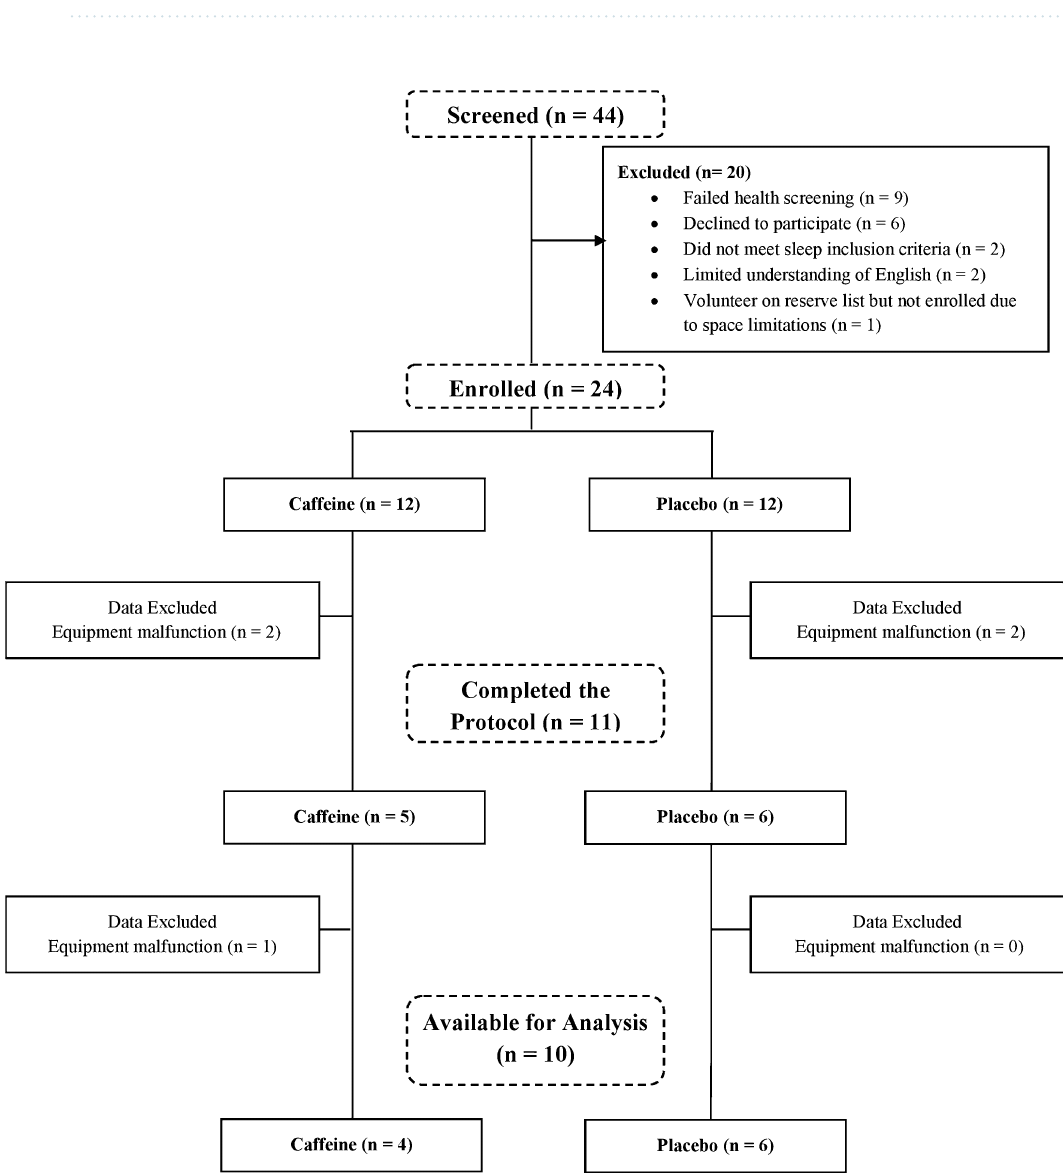
Figure 5. Consort diagram of participant screening, allocation to conditions, protocol completion and the resulting sample used in the current analysis. Adapted from 14